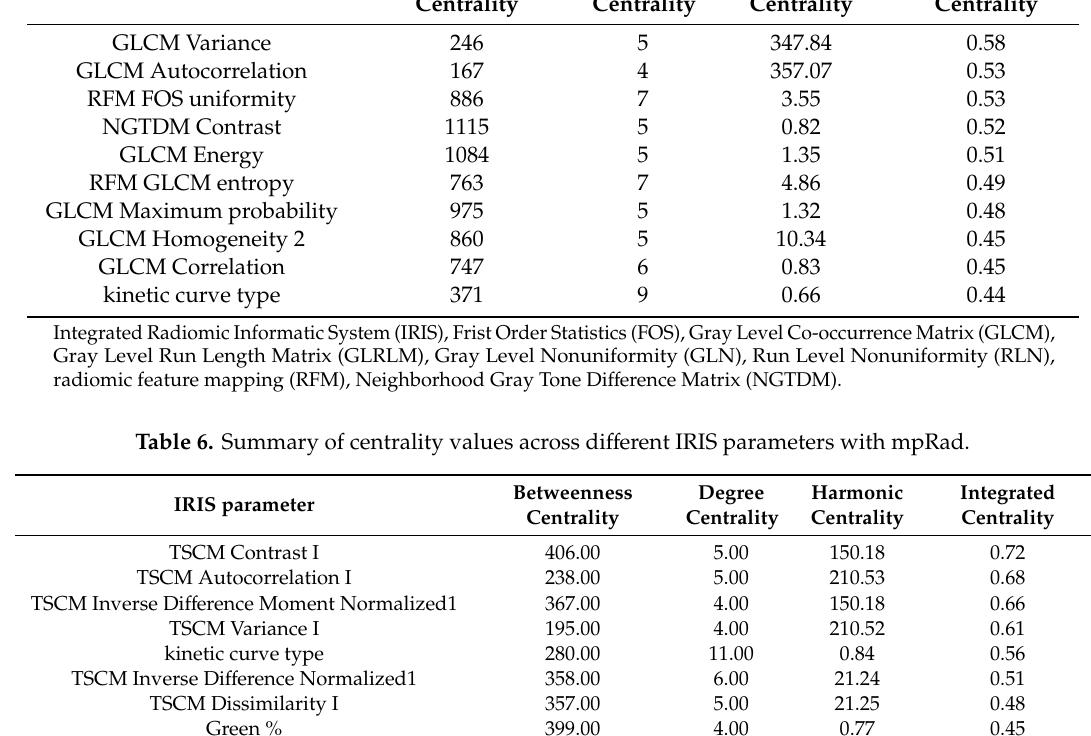
Table 5. Summary of centrality values across di ff erent IRIS parameters. IRIS Parameter